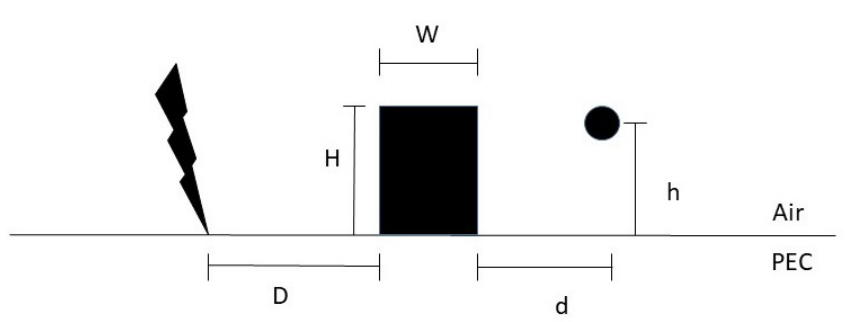
Figure 1. Considered geometry in the presence of